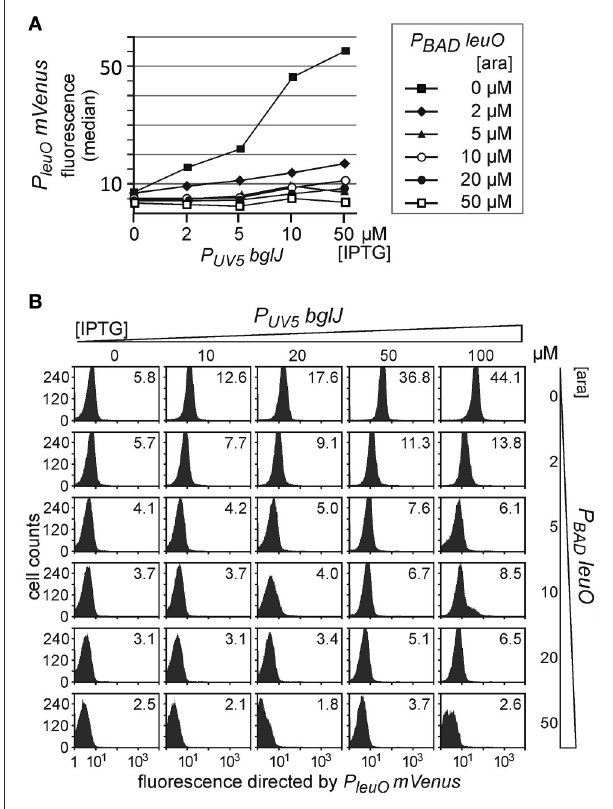
FIGURE 5 | Antagonistic regulation of P leuO mVenus transcription by BglJ and LeuO. Transformants of P leuO mVenus strain U69 with plasmids pKES303 ( P UV 5 bglJ ) and pKEHB28 ( P BAD leuO ) were grown for 5h in tryptone medium containing arabinose and IPTG at the indicated concentrations. Fluorescence was monitored by flow cytometry. (A) The median fluorescence is plotted against the IPTG concentration that was used for induction of bglJ . Each line graph represents the set of median fluorescence data that was obtained when plasmidic leuO was induced with the indicated arabinose concentrations. (B) Flow cytometry data of cultures grown with increasing IPTG (rows) and arabinose (columns) concentration (presentation of data as in Figure 4